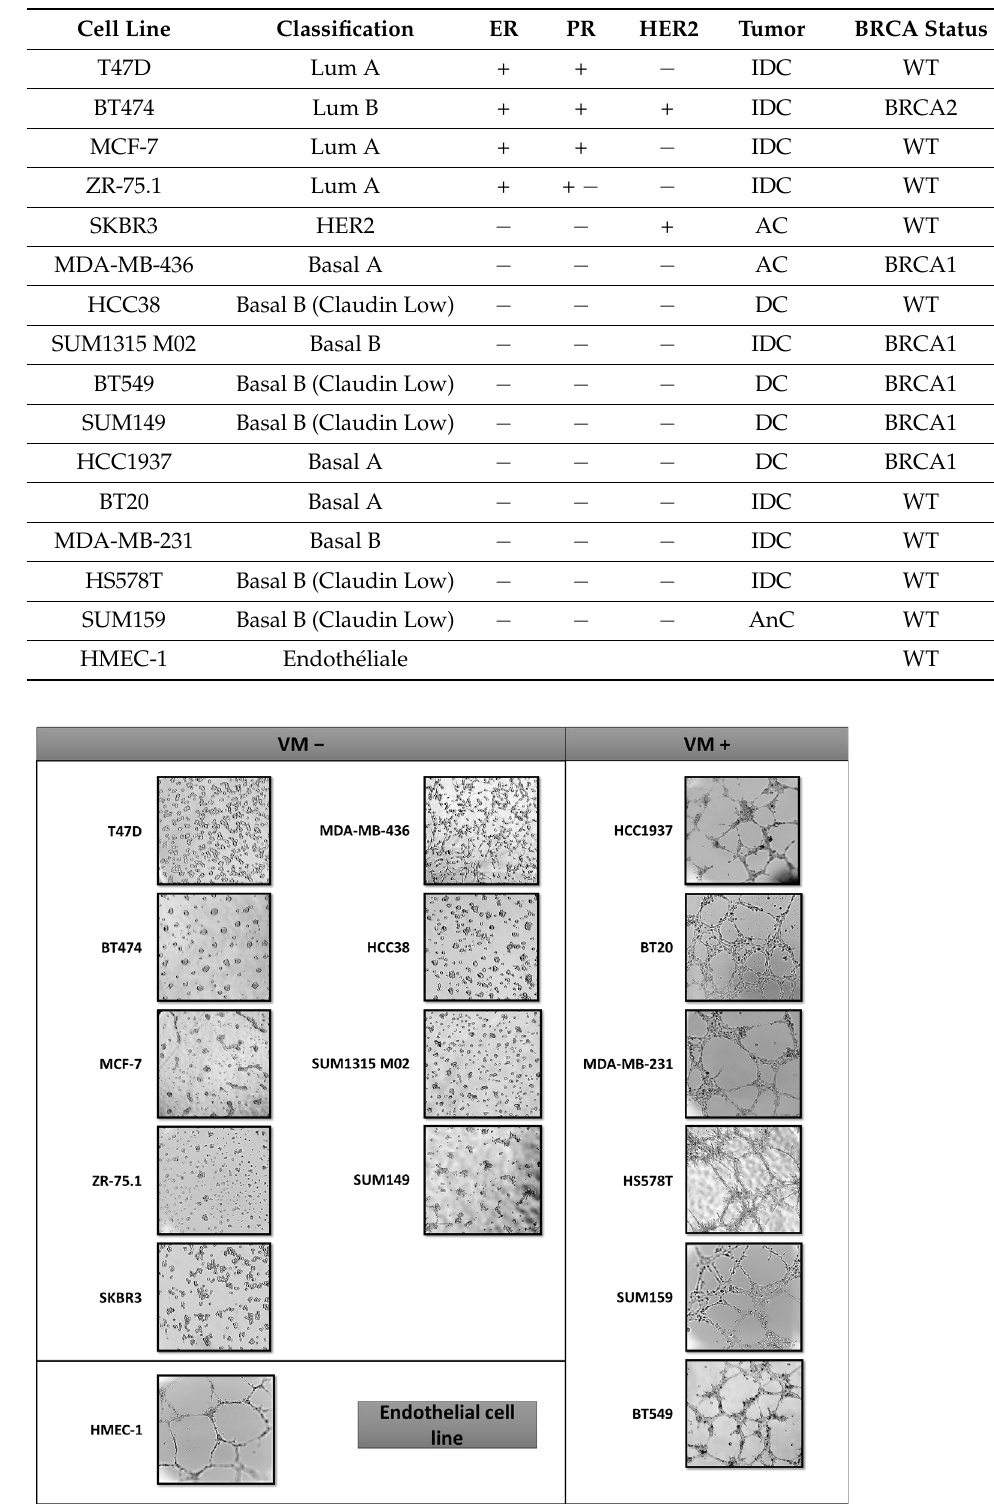
Table 1. Characteristics of the breast cancer cell lines used in this study. Lum A: luminal A; Lum B: luminal B; IDC: invasive ductal carcinoma; AC: adenocarcinoma; DC: ductal carcinoma; AnC: anaplastic carcinoma.